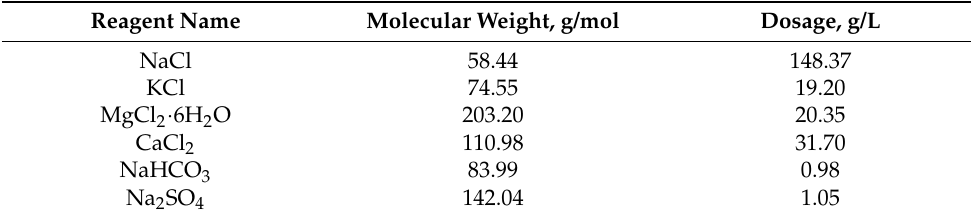
Table 5. Dosages of reagents used in preparing the simulated formation